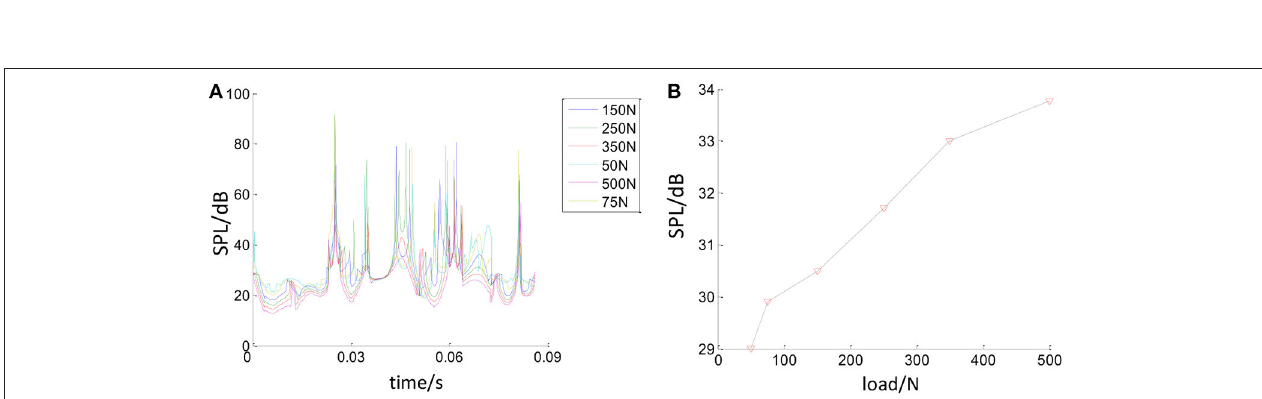
Frontiers in Mechanical Engineering |